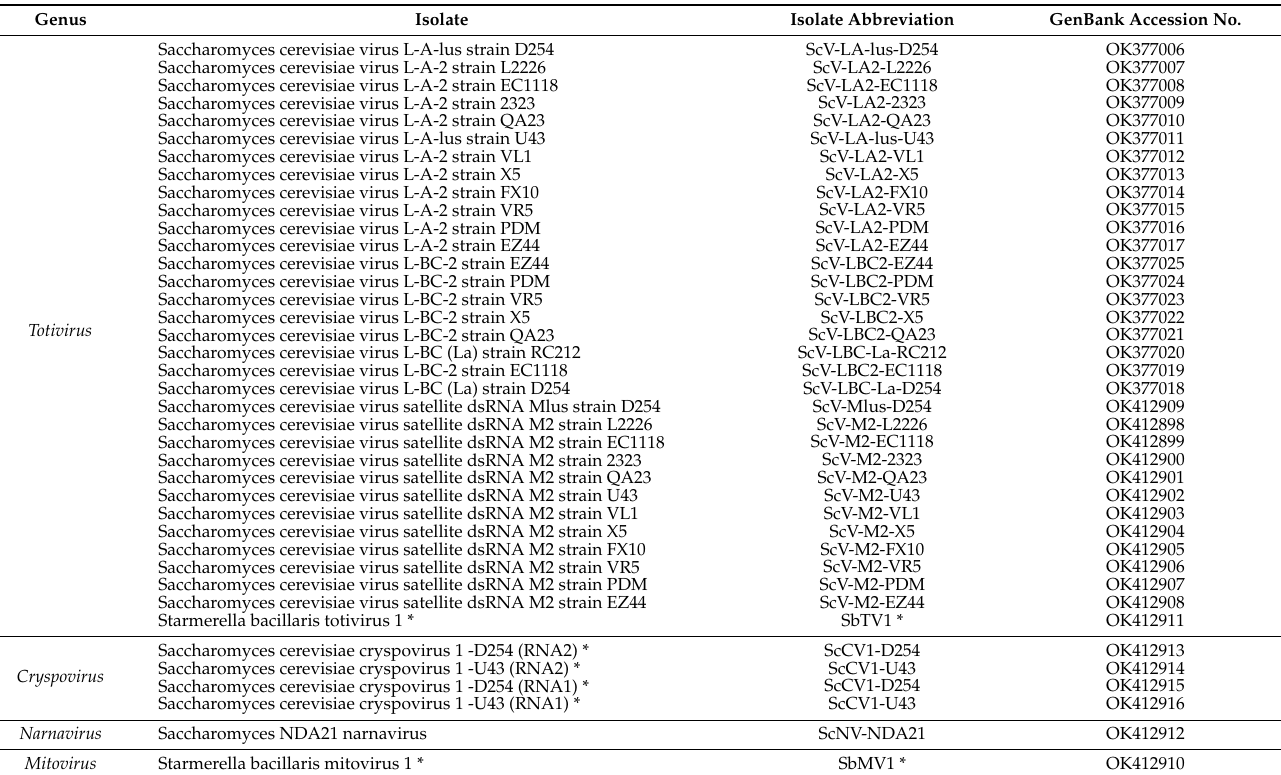
Table 2. List of viral isolates and corresponding GenBank accession numbers. Putative new viral species are indicated by